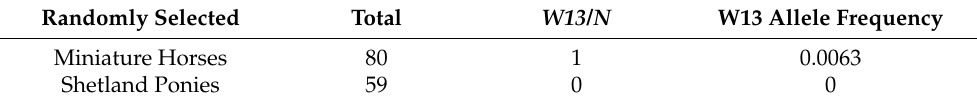
Table 4. Allele frequency of W13 in Miniature Horses and Shetland